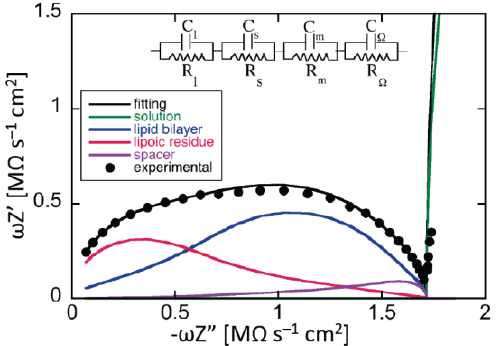
Figure 12. Plot of ωZ ′ (black circles) against – ωZ ″ for a mercury-supported DPTL/DPhPC bilayer immersed in aqueous 0.1 M KCl at −0.41 V vs. SCE. The black curve is the best fit of the impedance spectrum by the equivalent circuit shown in the inset, with R l = 17 M ·cm 2 , C l = 1.6 μF·cm −2 , R s = 0.18 M ·cm 2 , C s = 5.5 μF·cm −2 , R m = 4.2 M ·cm 2 , C m = 1.1 μF·cm −2 , R = 3.6 ·cm 2 , C = 27 nF·cm −2 . The colored curves are contributions to ωZ ′ from the single slabs.